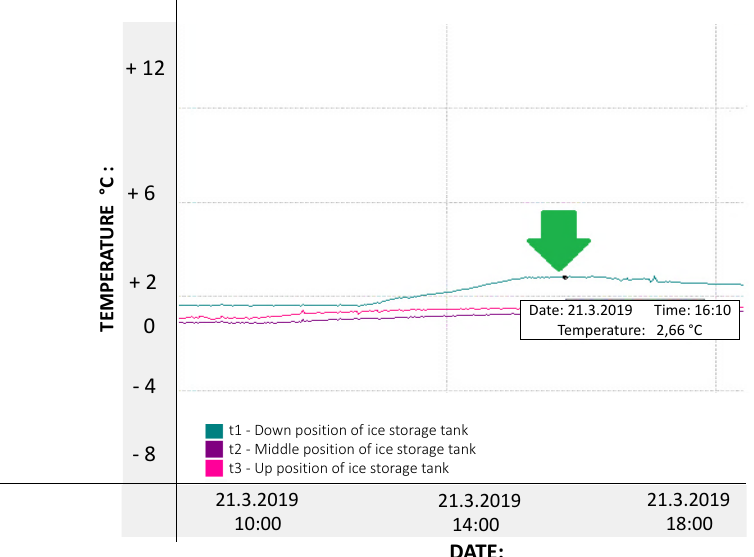
Figure 21. III. Phase—Melting ice t1.